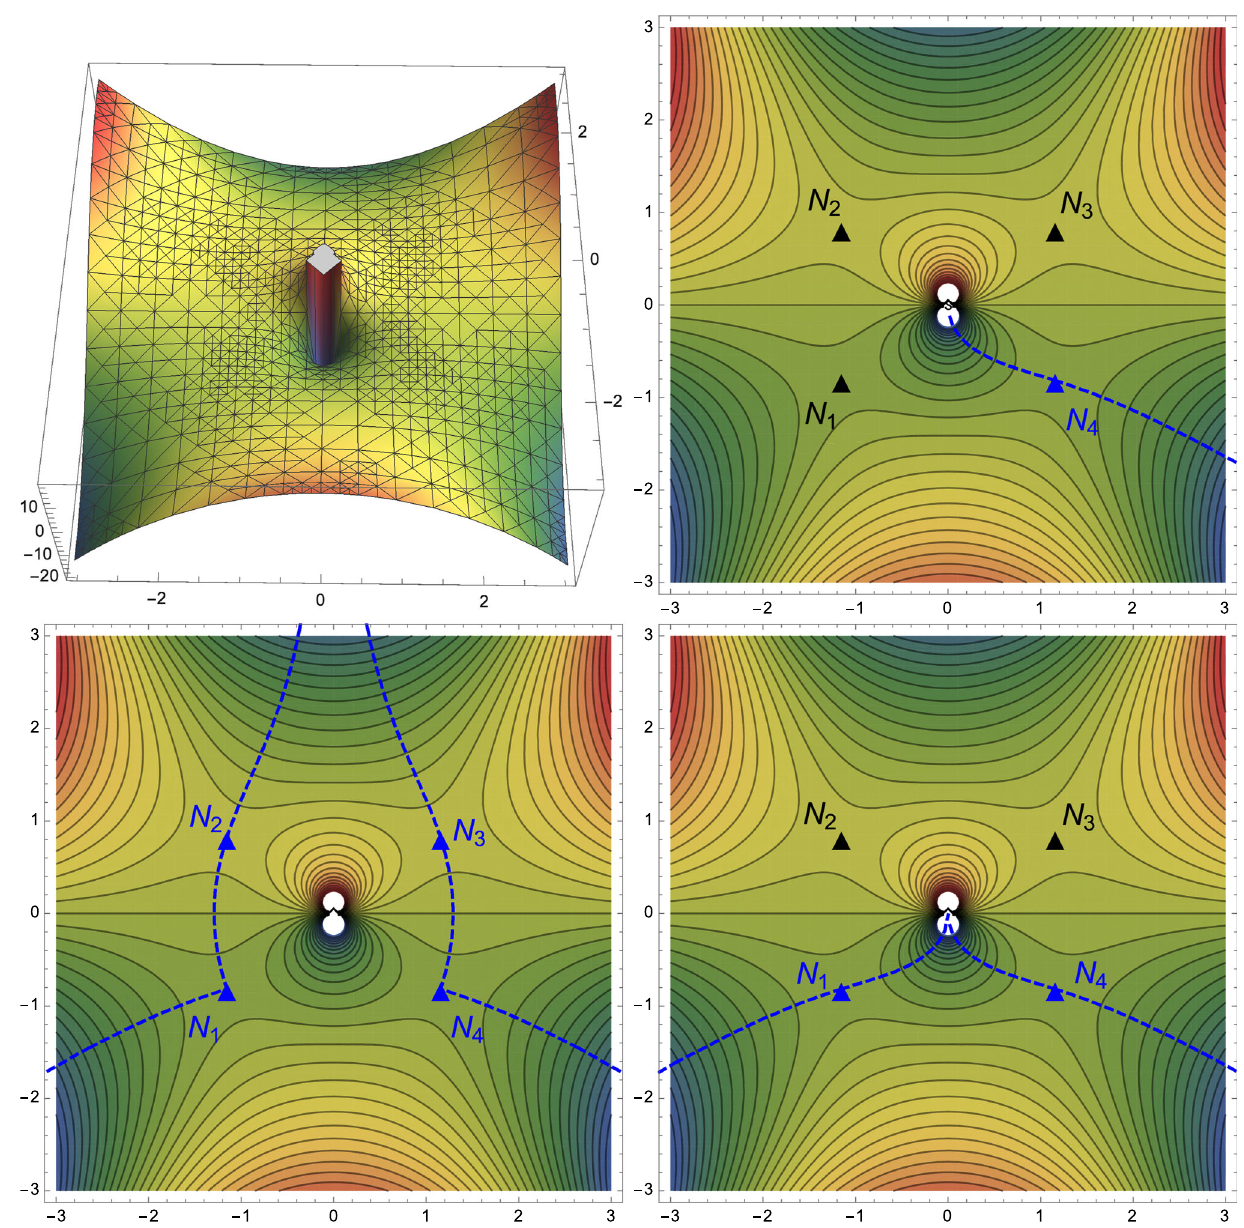
The upper right figure consider N = ( 0 , ∞ ) and a Lefschetz thimble with N 4 can be only chosen. The lower figures take N = ( −∞ , ∞ ) and we can chose two different contours where one pass all saddle points N 1 , 2 , 3 , 4 and another pass lower two saddle-points N 1 , 4 . We note that N 2 , 4 corresponds to the exponent of the WKB wave function and this point will be discussed in Sect.